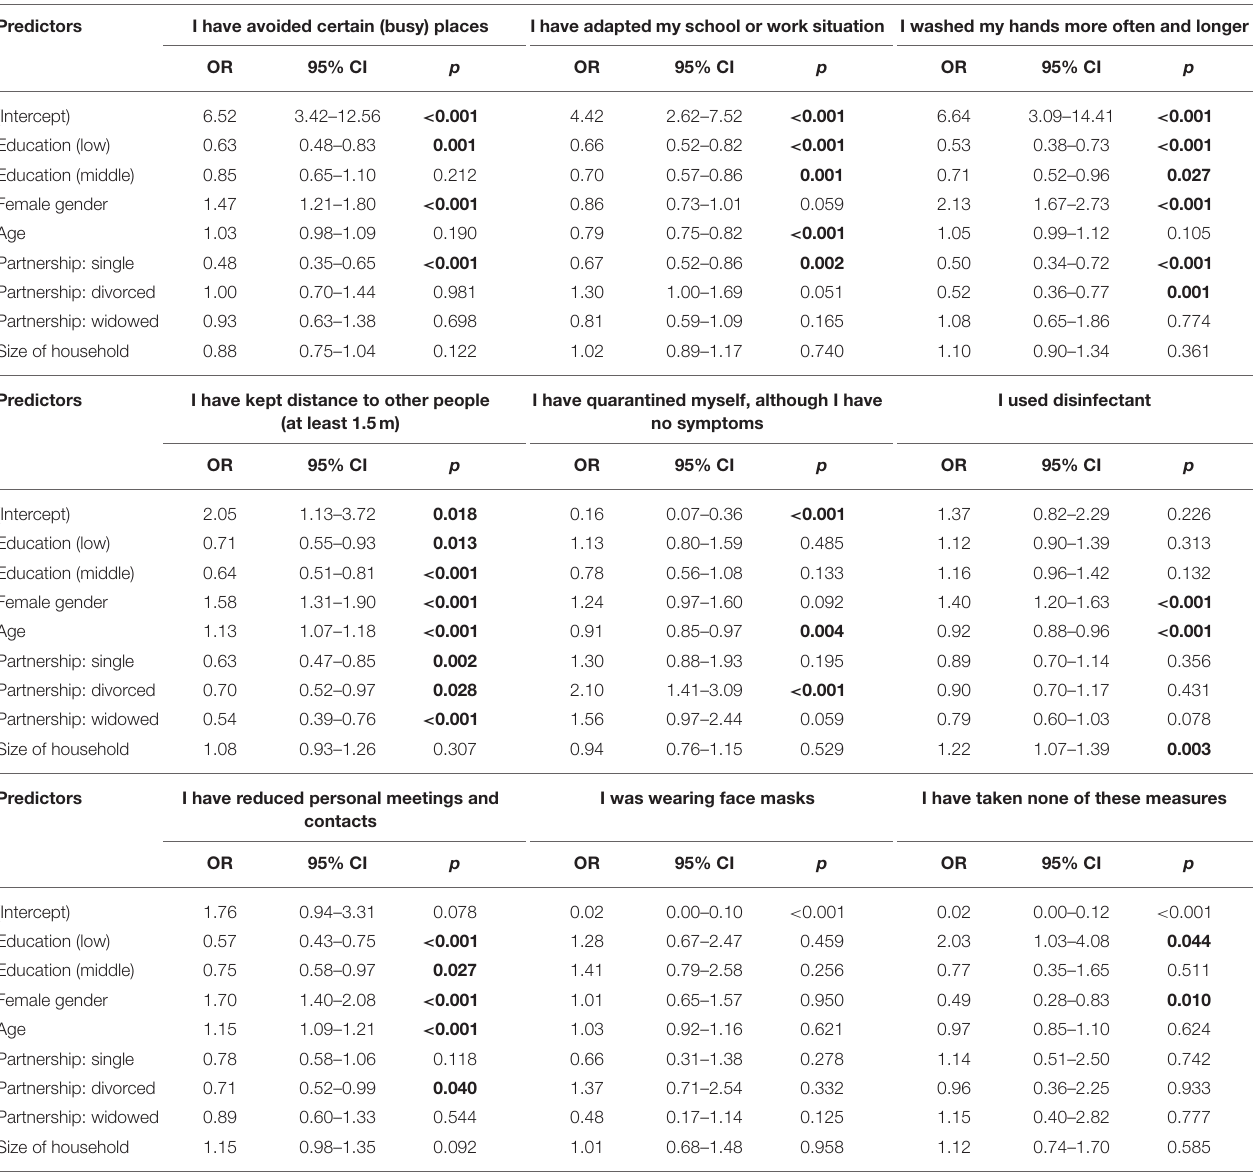
TABLE 3 | Results from the nine multiple logistic regression models on the association of socio-demographic factors and protective behavior.